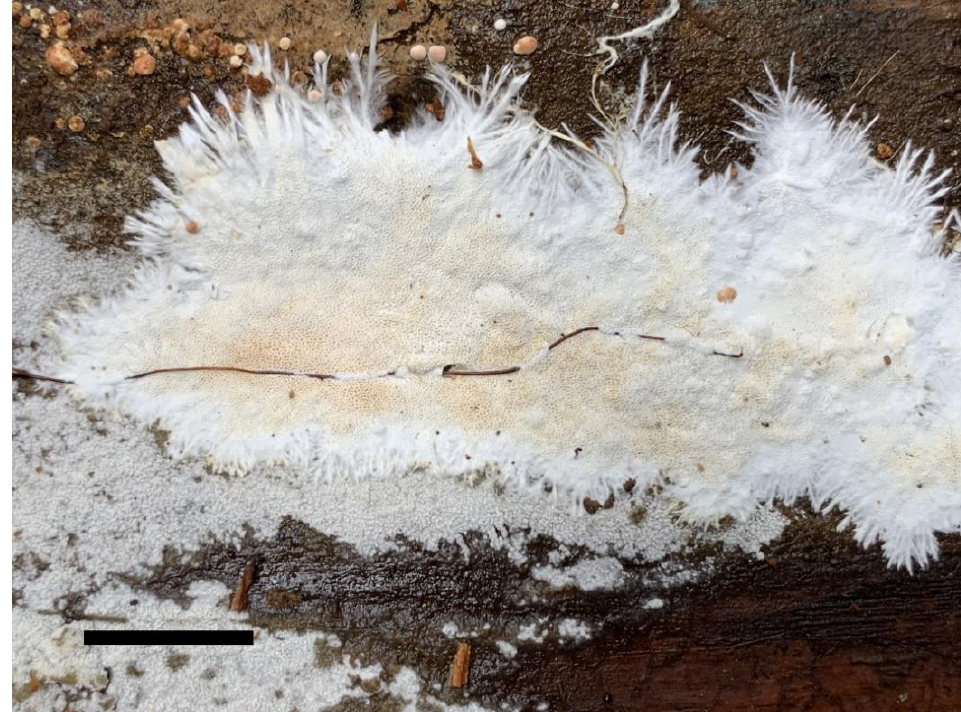
Figure 4. A basidiocarp of Anomoloma eurasiaticum (Dai 22860). Scale bar = 1.0 cm. MycoBank: